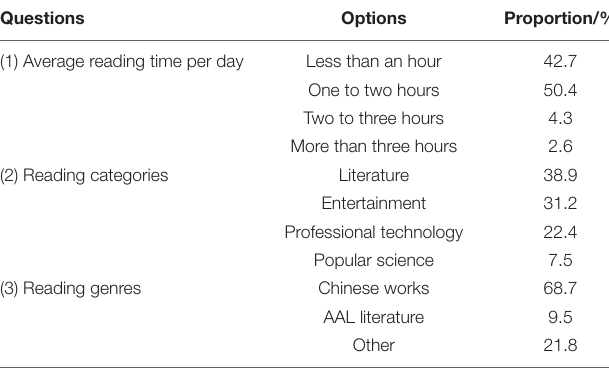
TABLE 4 | Statistics of literature reading time and types.